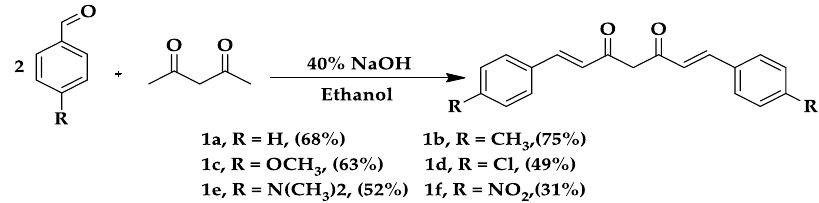
Figure 1. ( a ) Cholinesterase inhibitors ( b ) Chemical structure of natural curcumin ( c ) General struc- ture of curcumin